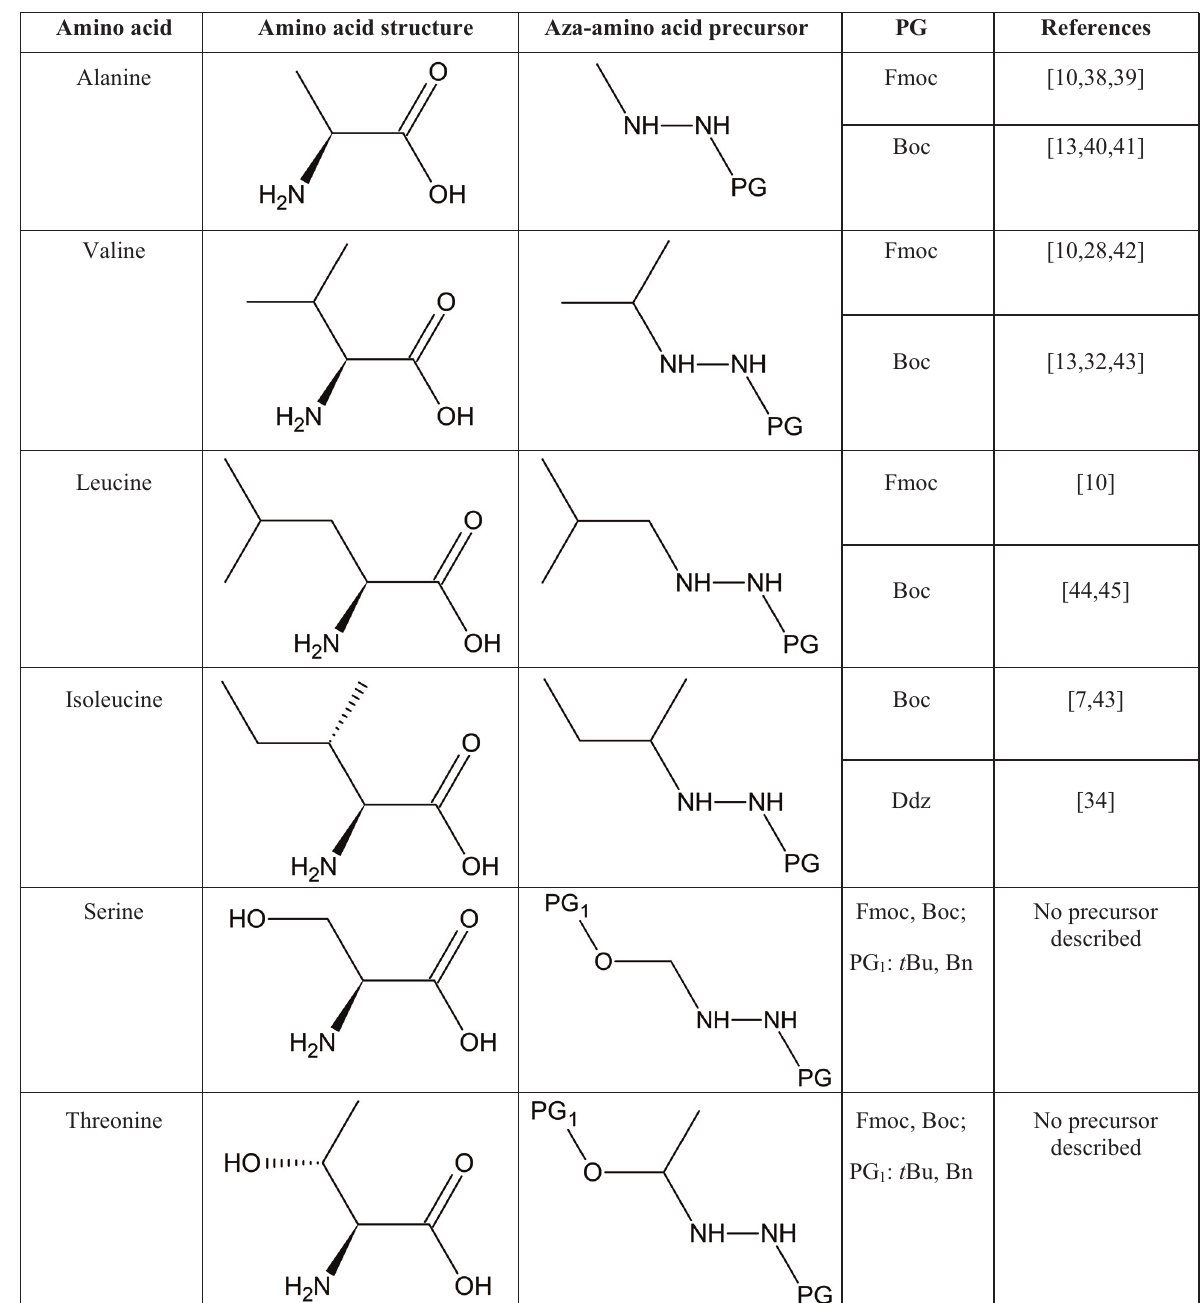
Table 1. Structures of DNA-encoded amino acids, corresponding α -aza-amino acid precursors, and references to the synthesis of these precursors with different protecting groups